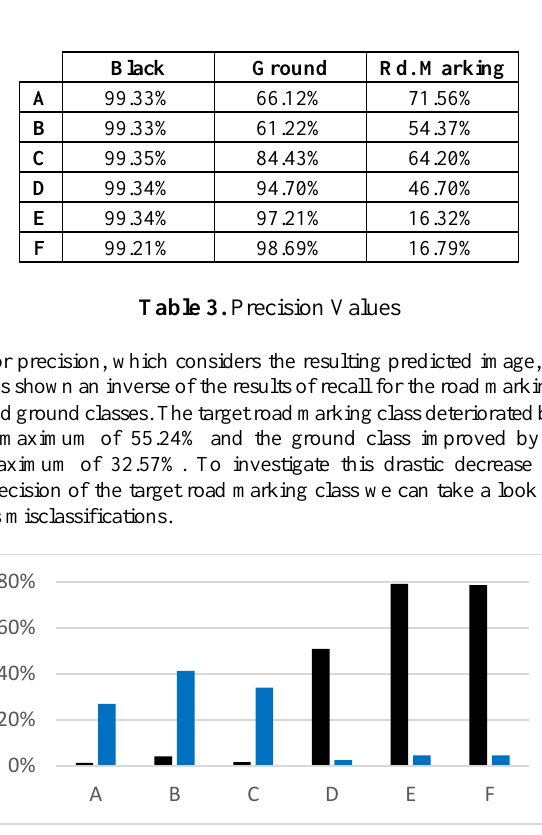
Figure 10. Road Marking Misclassifications (Precision)